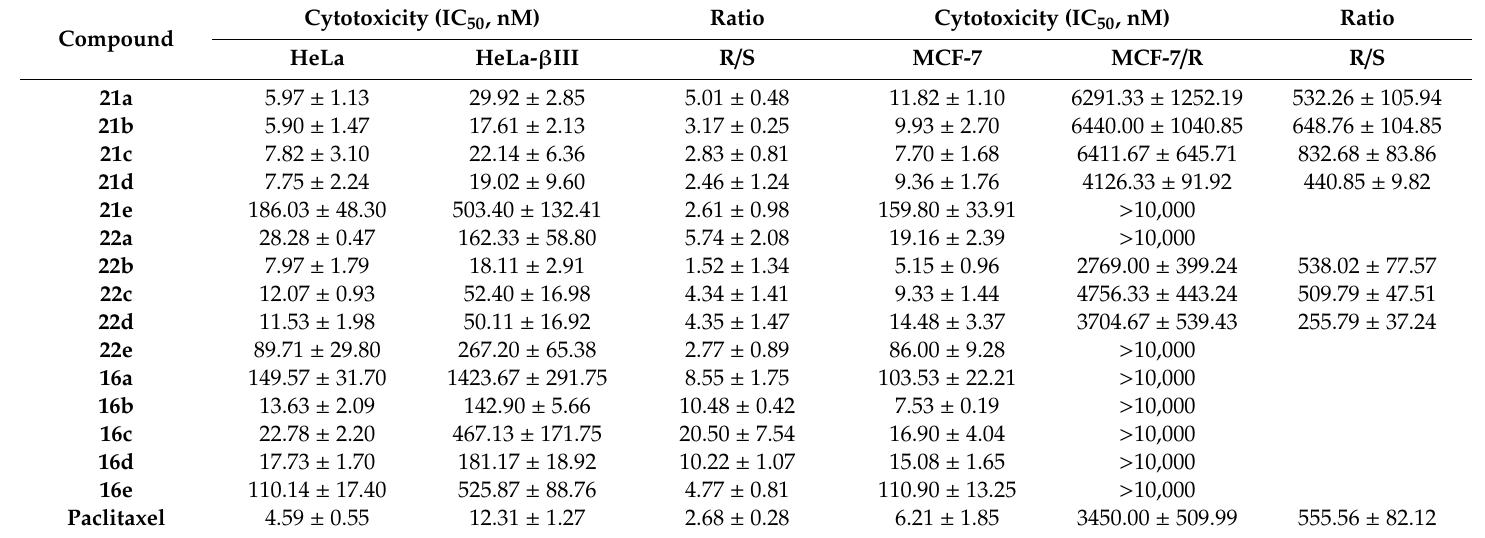
Table 1. Cytotoxicity of taxoids 16a – e , 21a – e , and 22a – e